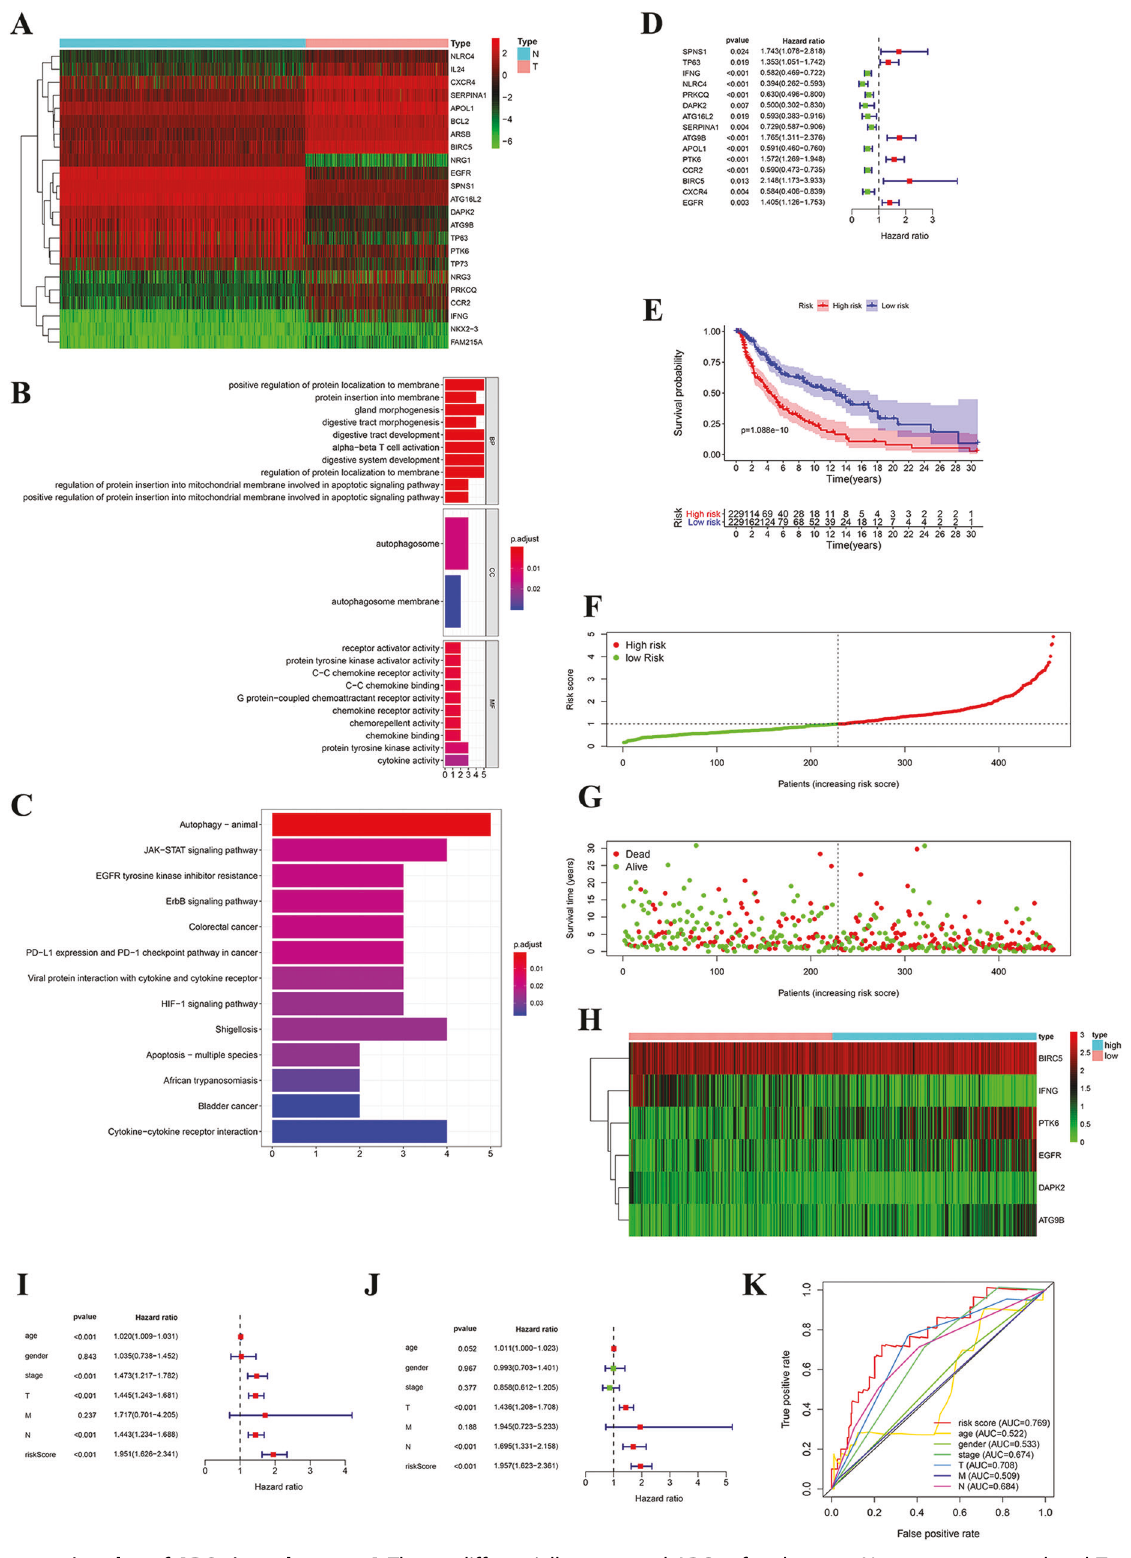
Fig. 1 Prognostic value of ARGs in melanoma. A The 23 differentially expressed ARGs of melanoma. N represents normal and T represents tumor. B , C GO and KEGG enrichment analysis of differentially expressed genes. D Forest plot of the prognostic signature for predicting patient OS by univariate Cox regression analysis. E OS curves for melanoma patients in the high-risk group and the low-risk group. F The risk score of each patient. G The survival status of each patient. H The expression heatmap of the six ARGs. I , J The clinical parameters in the univariate and multivariate Cox regression analyses. K The ROC curve of the risk score and clinical parameters in predicting the 5-year survival rate of melanoma patients.